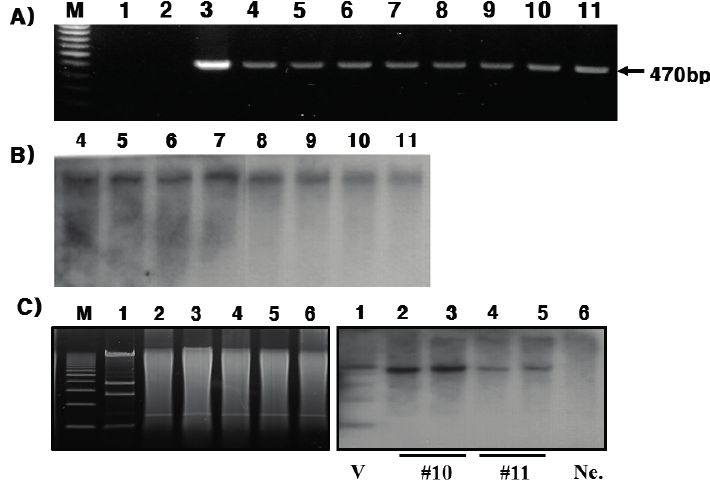
Figure 2. Transmission into the germline from transgenic mice. DNA was isolated from tail biopsies. DNA samples were digested with KpnI, run on 0.7% agarose gel, transferred to nitrocellulose membranes, and hybridized with hPC cDNA. ( A ) The second to fifth generations of transgenic mice were amplified by PCR from #10 and #11 lines. Lanes 1: Negative control without DNA; Lanes 2: Negative control with DNA; Lane 3: Positive control with hPC cDNA vector; Lanes 4–7: #10 line; Lanes 8–11: #11 line; ( B ) Southern blot results from heterozygotes DNA samples. Number 4–7: #10 lines; Number 8–11: #11 lines; ( C ) Southern blot results in the fifth generation of homozygous Tg mice were analyzed from #10 and #11 lines. Electrophoresis results from KpnI enzyme cut (left). Number 2–3: #10 line; Number 4–5: #11 line. V: Constructed vector; Ne.: Negative Control. M: